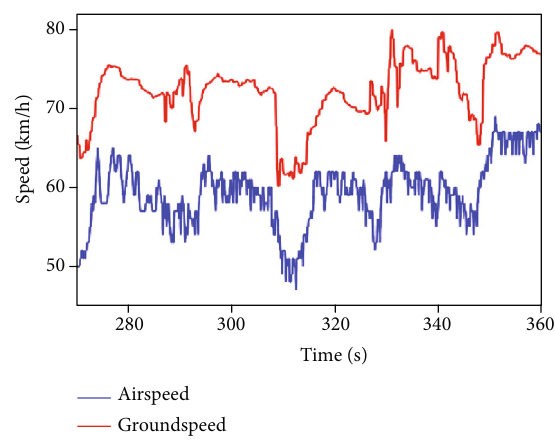
Figure 3: Comparison of the GNSS groundspeed (red) and the pitot tube airspeed (blue) in the case of